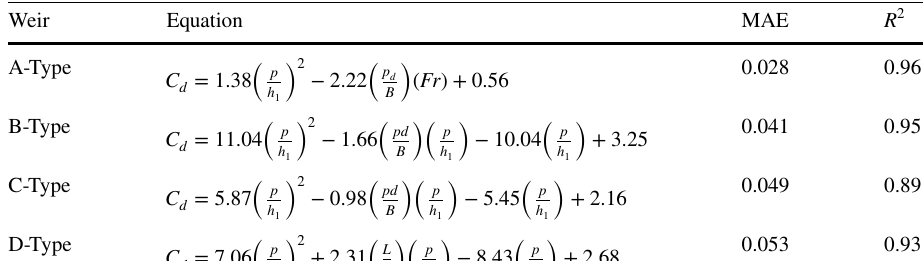
Fig. 13 Evaluation of the accu- racy of the proposed